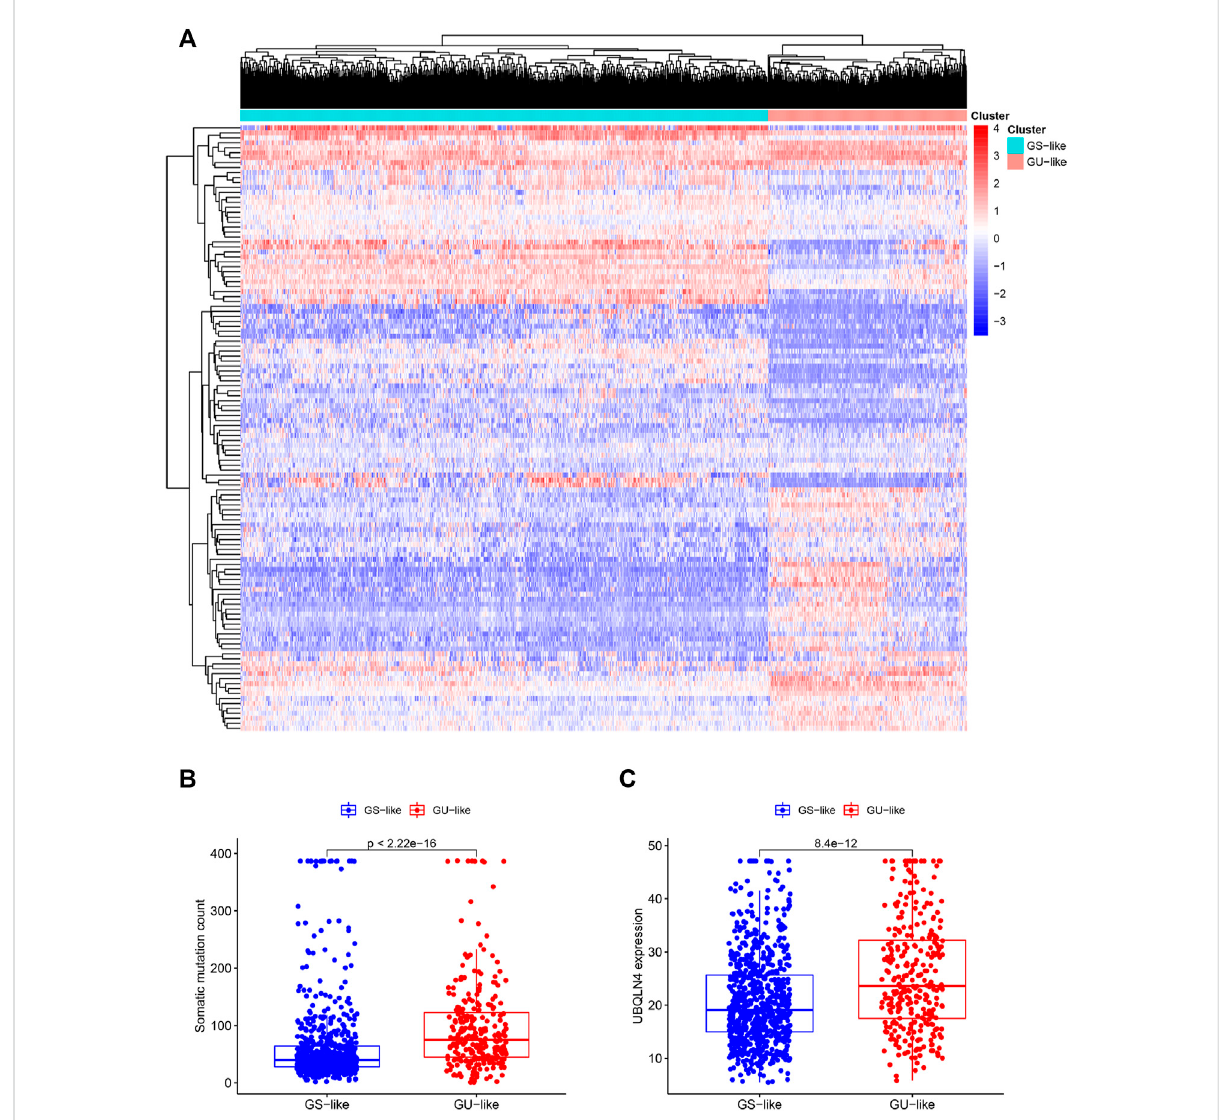
FIGURE 2 Hierarchical clustering of breast cancer patients and the characteristics between the groups. (A) . Hierarchical clustering of 1,066 breast cancer patients based on the expression pattern of 122 candidate genetic instability-derived lncRNAs. The left blue cluster was the GS-like group ( n = 774), andtherightredclusterwastheGU-likegroup( n =292). (B) .Boxplotofsomaticmutationscountbetweentwogroups. (C) .UBQLN4expressionlevel between these two